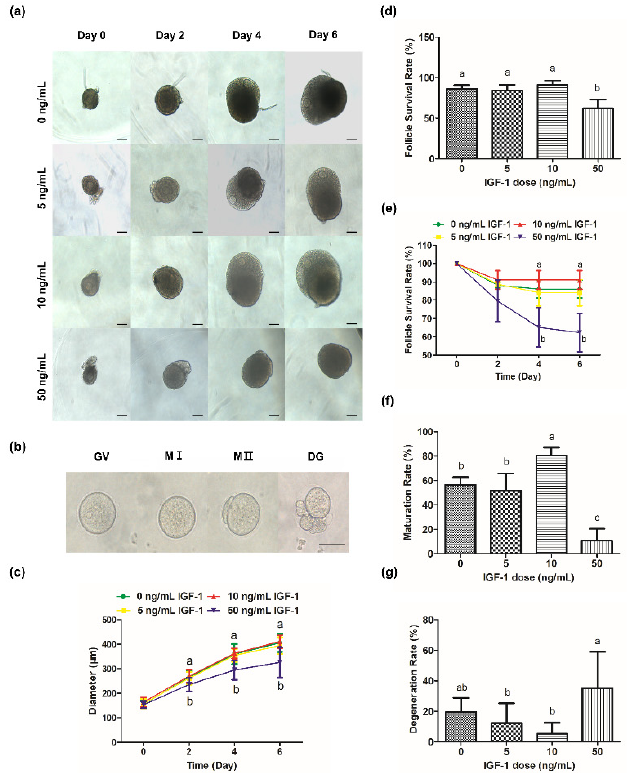
Figure 2. Effects of IGF-1 on mouse follicle growth and oocyte maturation. ( a ) Images of follicular growth in media containing different concentrations of IGF-1 (0, 5, 10, and 50 ng/mL) from day 0 to day 6; ( b ) Images of GV, MI, MII, and DG (degeneration) oocytes after IVM; ( c ) Line graph of change in follicle diameters in media containing different concentrations of IGF-1 from day 0 to day 6; ( d ) Follicle survival rates at day 6 in media containing different concentrations of IGF-1; ( e ) Line graph of change in follicle survival rates in media containing different concentrations of IGF-1 from day 0 to day 6; The maturation ( f ) and degeneration ( g ) rates of oocytes after IVM were isolated from follicles treated with different concentrations IGF-1 for 6 days. Scale bar in ( a ): 100 µm; ( b ): 50 µm. Error bar: standard deviation; points or bars with completely different letters (a, b, c) indicating significant difference among treatments for isolated time points ( p < 0.05). n = 10 follicles for five replicates.